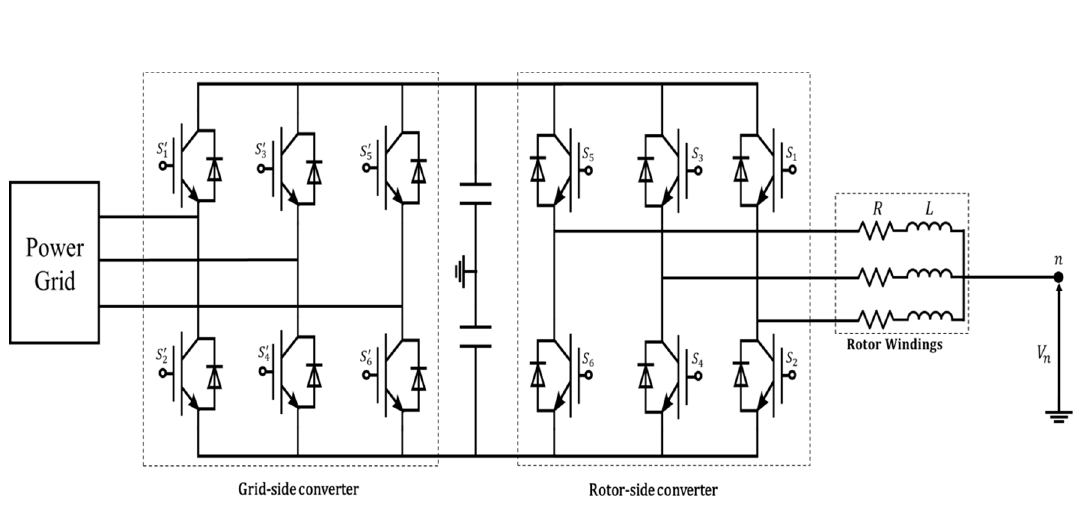
Figure 1. Three-phase pulse-width modulated power converter connecting rotor winding to power grid.